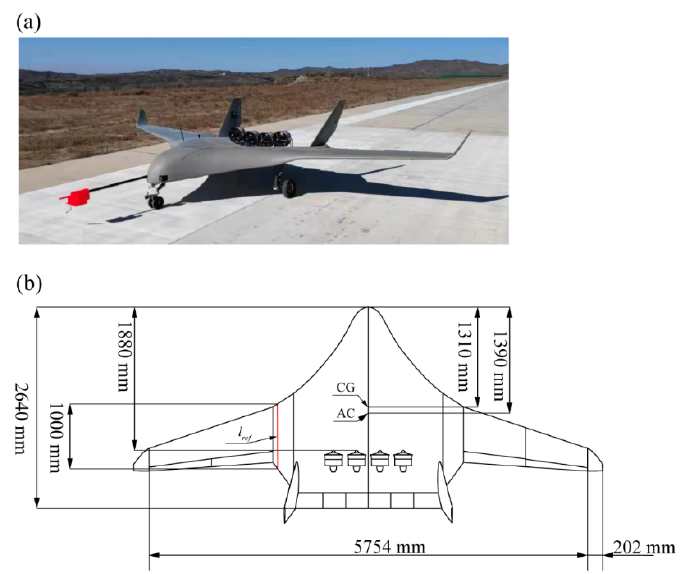
Figure 1. The scaled ‐ down distributed propulsion demonstrator (DPD). ( a ) Actual model for flight tests; ( b ) Schematic diagram showing the geometric parameters of the BWB airframe and the installation position of the fans. Table 1. Detailed design parameters of the scaled ‐ down DPD.